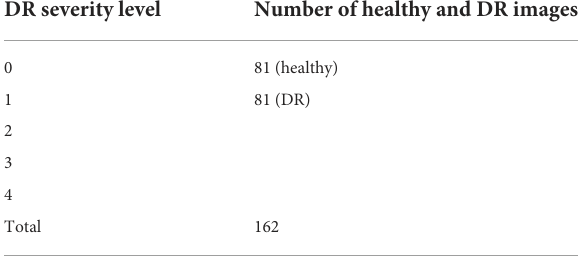
TABLE 2 Number of healthy and DR images in the testing